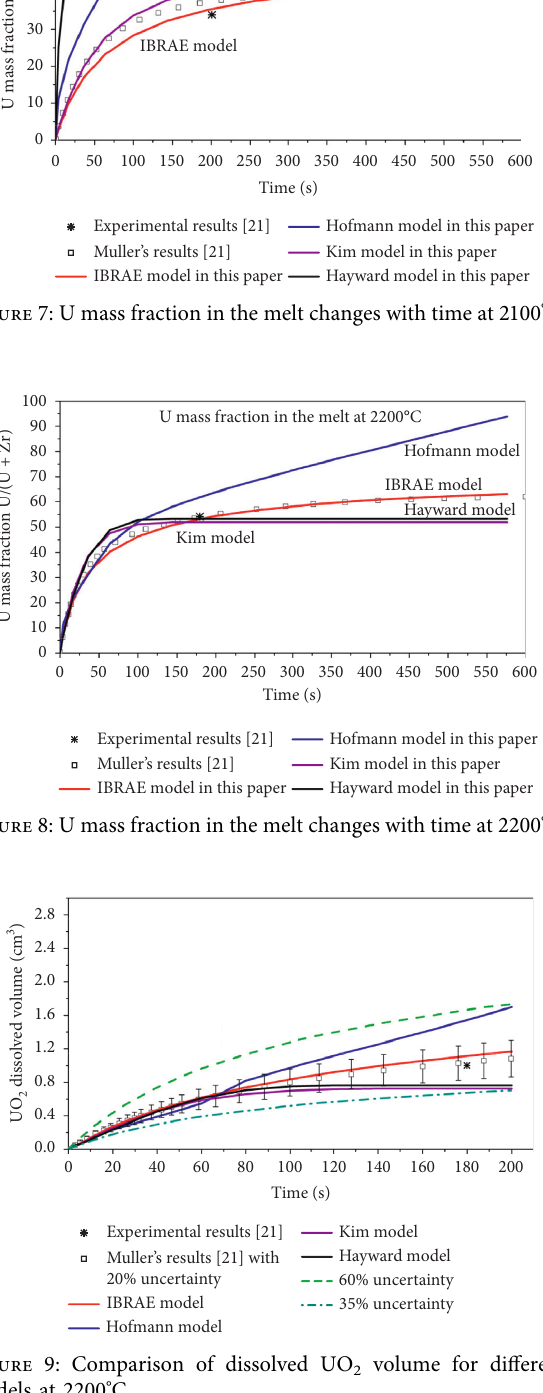
2 volume for different